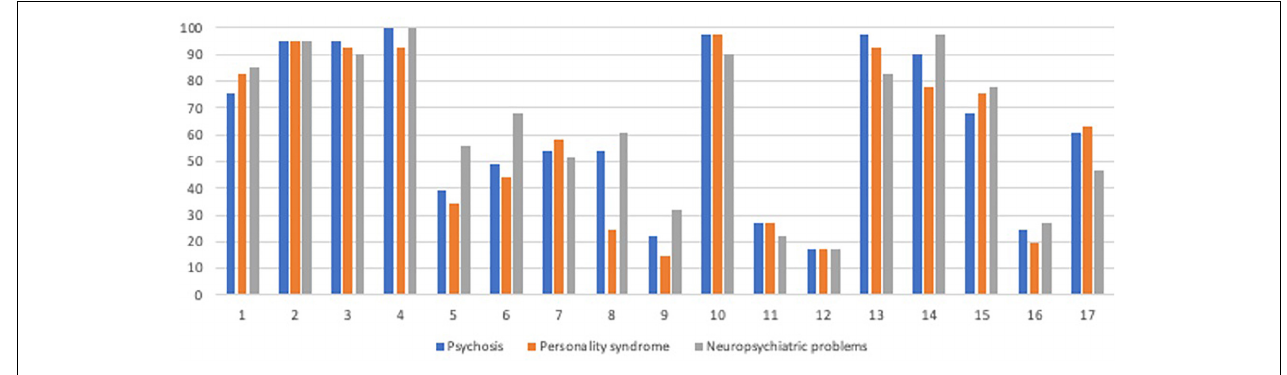
FIGURE 4 | Percentage of participants who requested the information source per case. comparisons made, differences found at p = 0.05 between cases regarding information sources were reported here for transparency’s sake, but only those which met the Bonferroni- corrected alpha-level were referred to as significant (adjusted: p = 0.003; 17 analyses made—see Figure 4 for an overview of all results). The significant differences are outlined